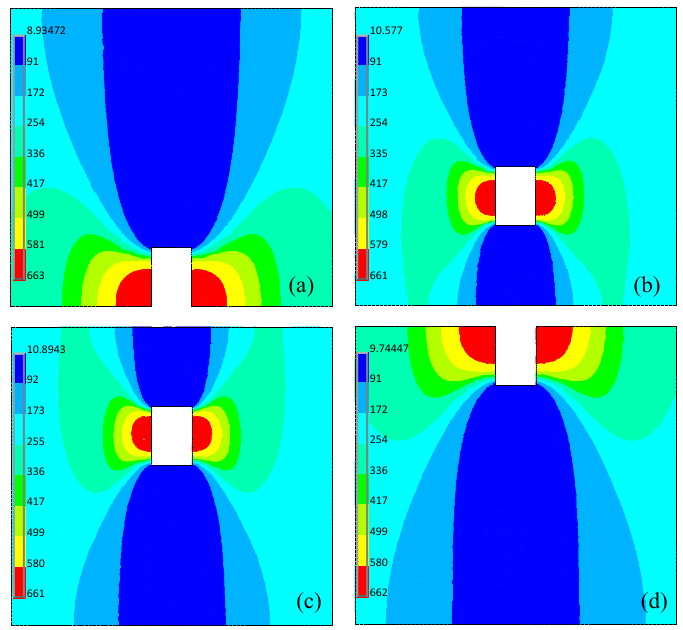
Figure 10. Permeability cloud map of different buried depth defects. ( a ) far-side surface defect; ( b ) and ( c ) internal non-surface opening defects; ( d ) near-side surface defect.